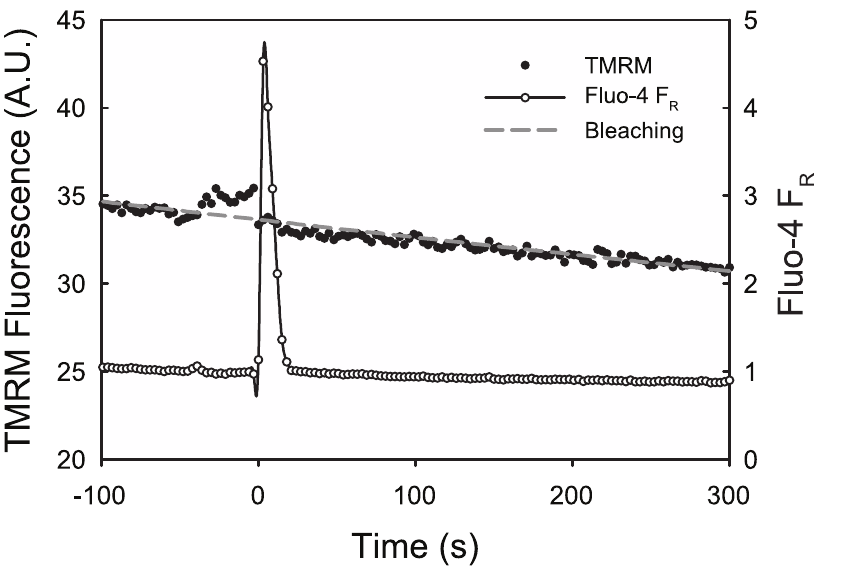
Figure 5. Pre-treatment with PKC a inhibitor Go¨6976 prevents air bubble-induced mitochondrial depolarization. Representative trace of fluorescence signals obtained from HUVEC loaded with DY m indicator TMRM (left axis, solid circles) and intracellular calcium dye Fluo-4 (right axis, open circles) responding to air bubble contact at t=0 following pre-treatment with 5 m mol/L Go¨6976. Dashed grey line represents the expected exponential decay of the signal, primarily due to photobleaching.